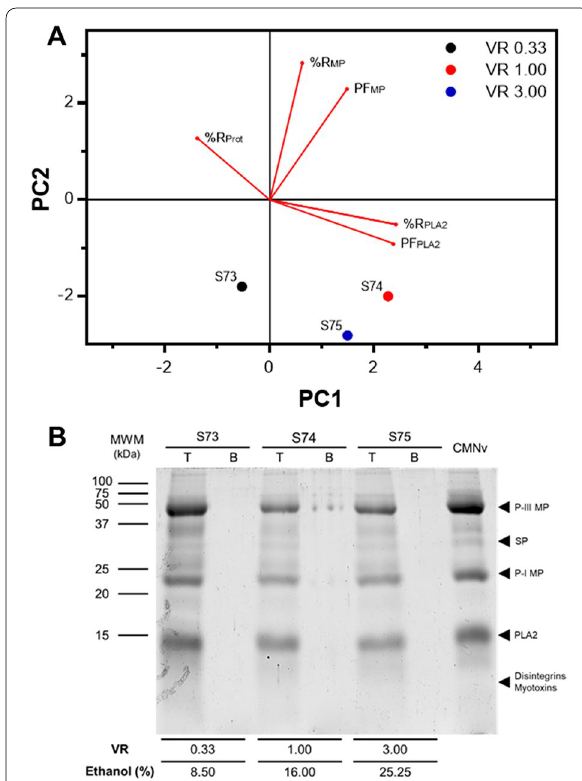
Additional file 2: Figure S1. Densitometric analysis of MPs and PLA2 bands from SDS‑PAGE ATPS systems. A) densitometric analysis of the